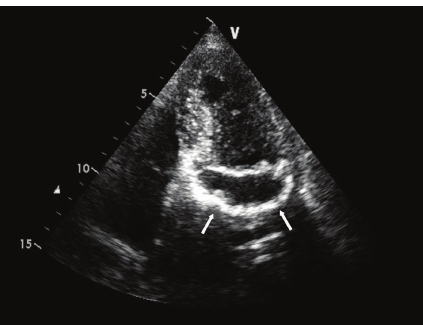
Figure 1: Echocardiographic apical four-chamber view showing a large oval echolucent mass with echodense rim in the mitral annular region.